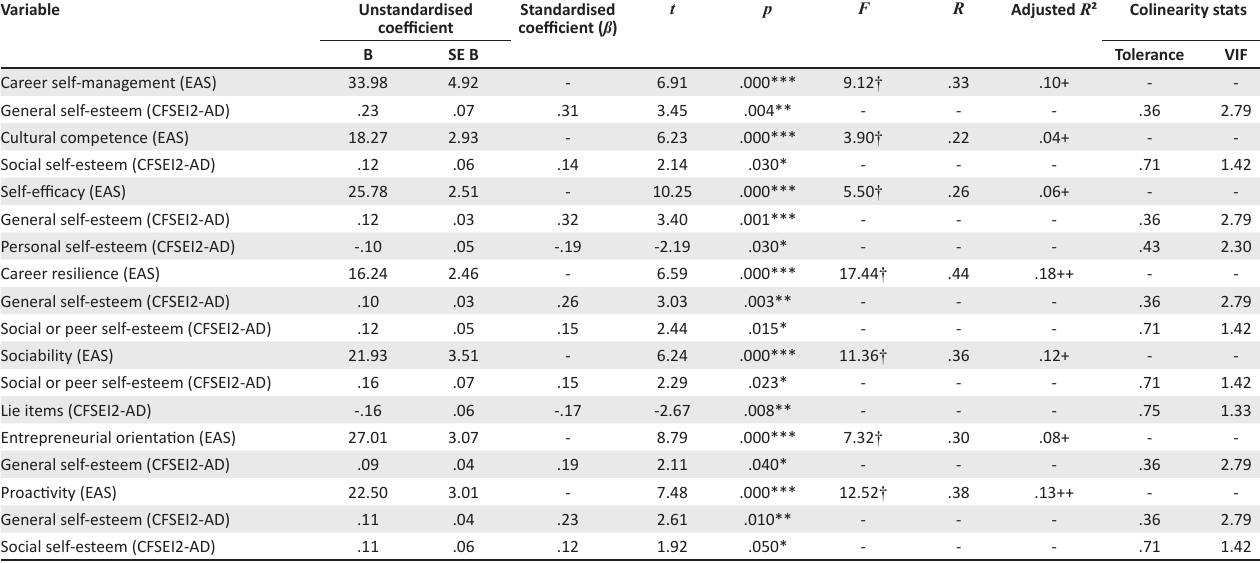
TABLE 5: Multiple regression analyses – Culture Free Self-Esteem Inventory and Employability Attributes